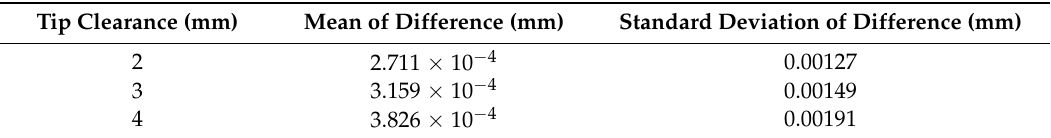
Table 1. Differences between the vibration displacements obtained by the two systems under different tip clearances.